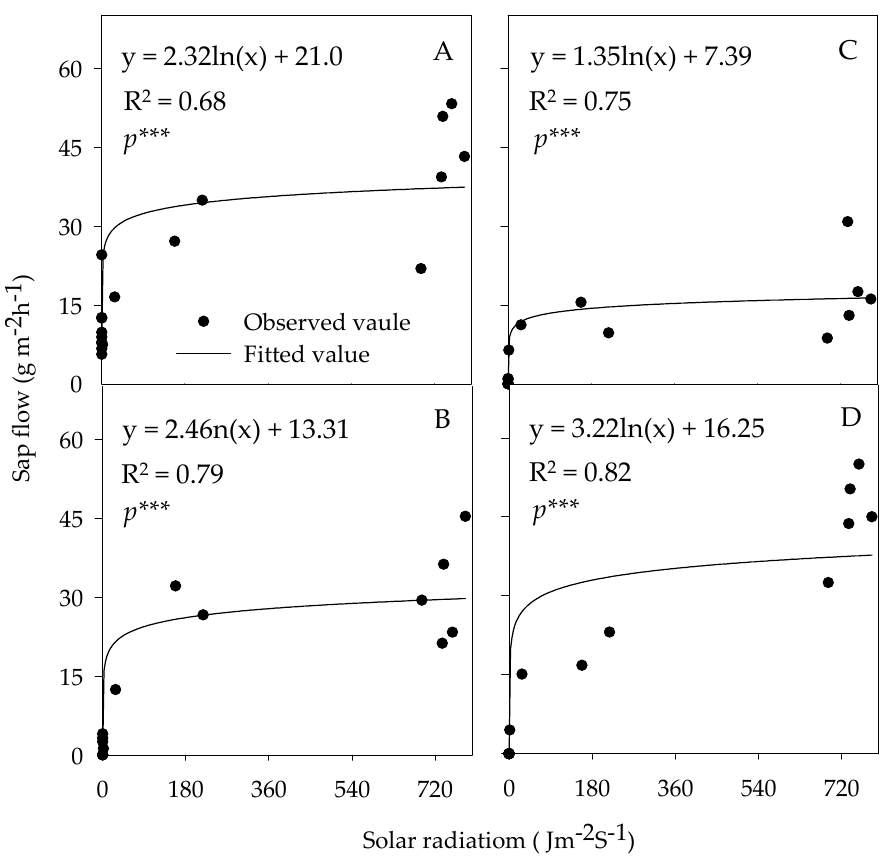
Figure 4. The logarithmic regression of sap flow and solar radiation of Huanglongbing (HLB)-affected Hamlin citrus trees budded on Swingle rootstocks under control ( A ), full Ca dose ( B ), full Mg dose ( C ), and half Ca and half Mg doses ( D ), (full dose = 45 kg ha − 1 ) treated trees. NS, *** Non-significant or significant at p < 0.0001.